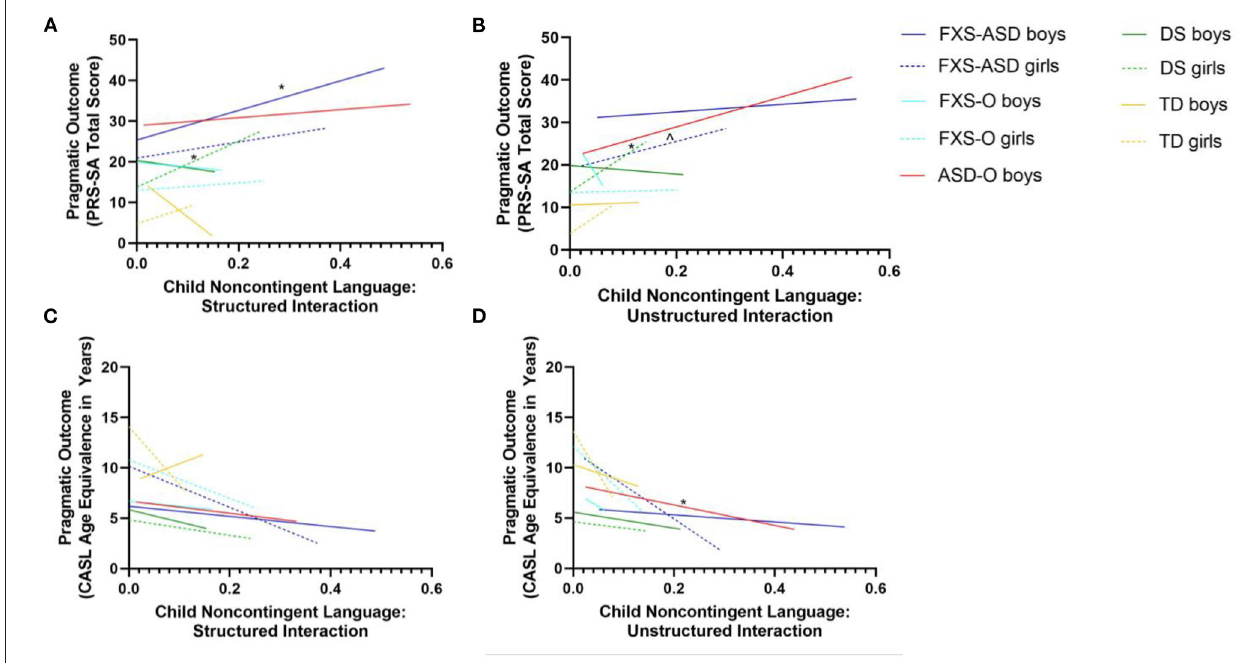
FIGURE 1 | (A–D) Non-contingent language and pragmatic language outcomes. Associations between non-contingent language and pragmatic language outcomes. (A) Increased rates of non-contingent language in the structured interactions were significantly associated with poorer pragmatic language outcomes, as measured by the PRS-SA, in FXS-ASD boys and DS girls. (B) Increased use of non-contingent language in the unstructured interactions was correlated with poorer pragmatic language outcomes, as measured by the PRS-SA, in the FXS-ASD girls and DS girls. (C) There were no significant associations between non-contingent language and pragmatic language outcomes, as measured by the CASL, in any groups. (D) Increased rates of non-contingent language in the unstructured interactions was significantly associated with poorer pragmatic language outcomes on the CASL in boys with ASD. FXS-ASD, fragile X syndrome with autism spectrum disorder; FXS-O, FXS only; ASD-O, ASD only; DS, Down syndrome; TD, typical development. ∧ p < 0.1, * p < 0.05.